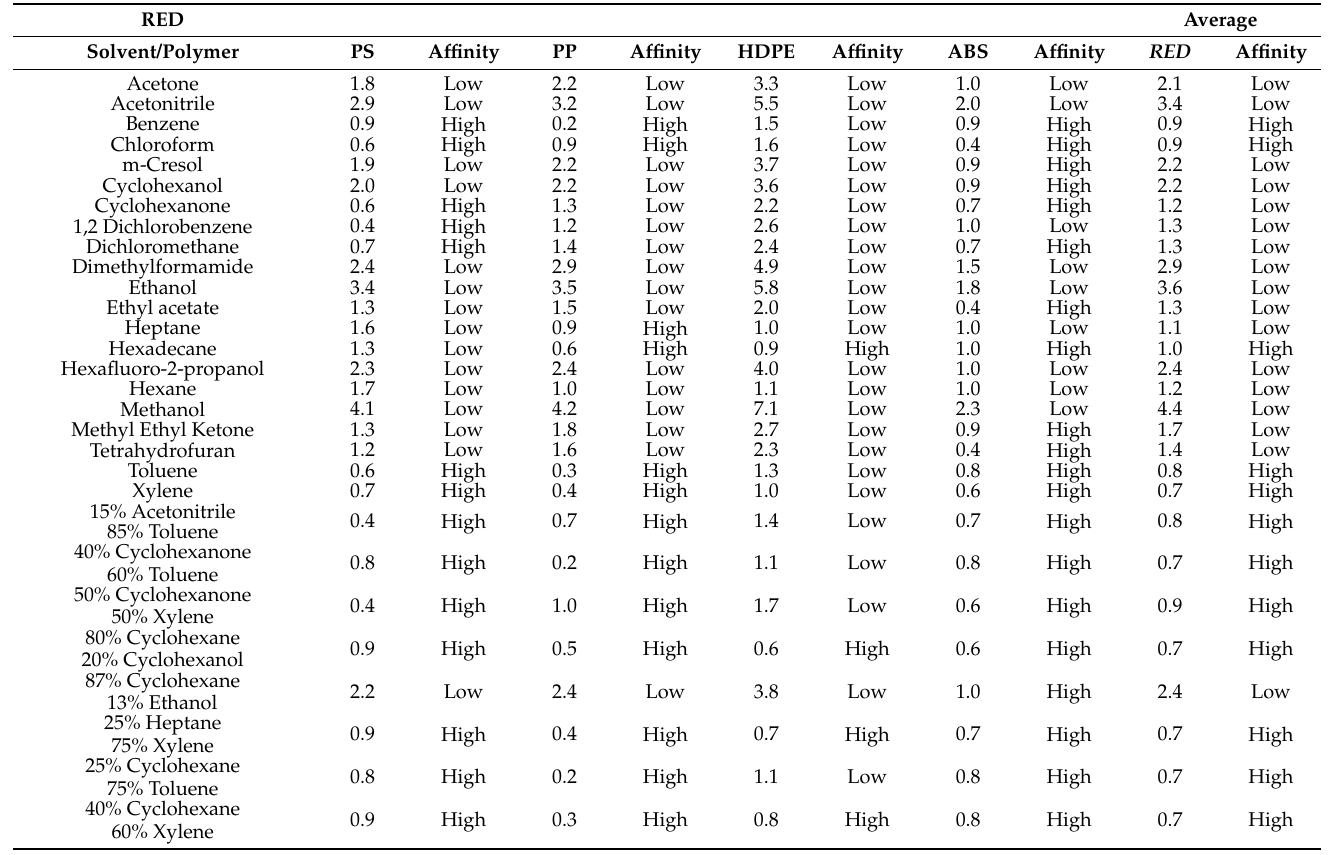
Table 1. Affinity of plastic solubility in various solvents using the Hansen solubility method of Relative Energy Difference.